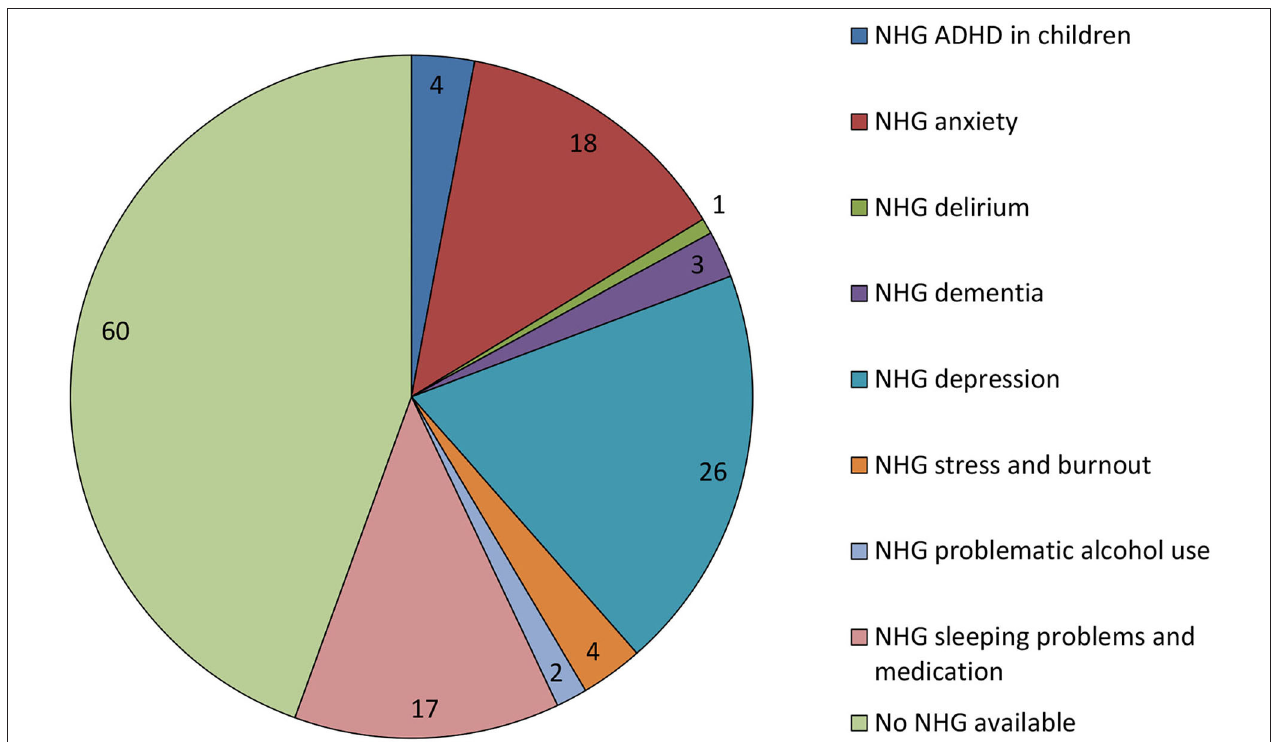
FIGURE 2 | Number of cases with and without NHG guidelines. This figure shows the number of cases with and without guidelines from the Dutch College of General Practitioners (NHG, Nederlands Huisartsen Genootschap ), including the number for each relevant guideline.